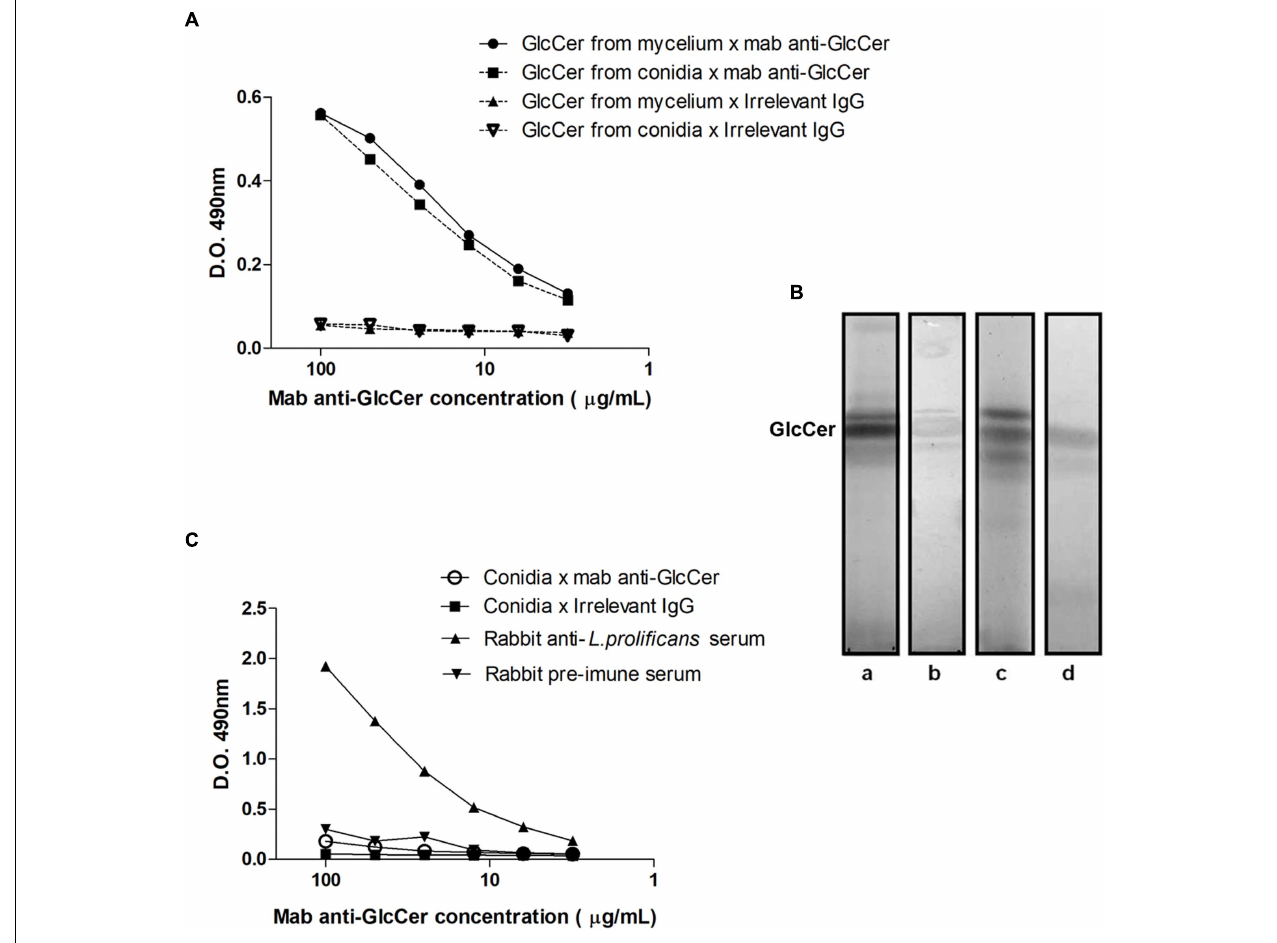
FIGURE 3 | Reactivity anti-GlcCer mAb with GlcCer species from L. prolificans . (A) ELISA of mAb binding to GlcCer species from mycelial and conidial forms of L. prolificans . Irrelevant IgG antibody was used as a negative control. (B) Immunostaining of GlcCer species from mycelial and conidial forms of L. prolificans . HPTLC was developed with CHCl3:MeOH:NH 4 OH 2 M (40:10:1 v/v). (Columns a and c ) Orcinol/H 2 SO 4 positive fractions for the mycelium and conidium, respectively; and (columns b and d) Reactivity of the anti-GlcCer mAb with the GlcCer species from mycelium and conidium forms, respectively. (C) Binding of anti-GlcCer mAb to the conidia of L. prolificans . Rabbit anti- L. prolificans serum was used as a positive control. The ELISA was performed in